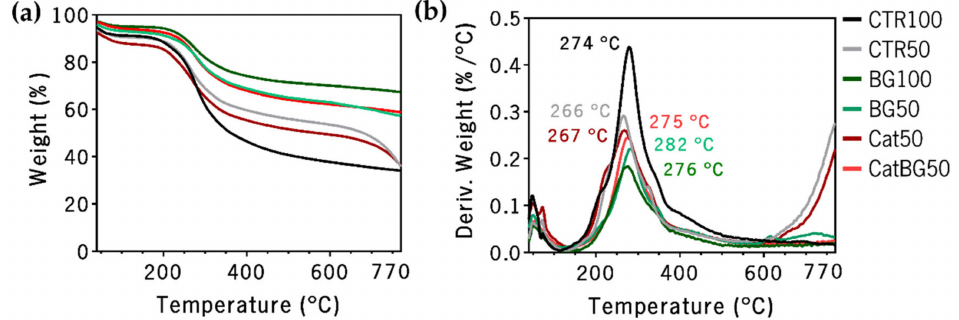
Figure 8. TGA thermograms of ( a ) weight loss and ( b ) derivative of the weight loss (DTGA) of the freestanding LbL films as a function of